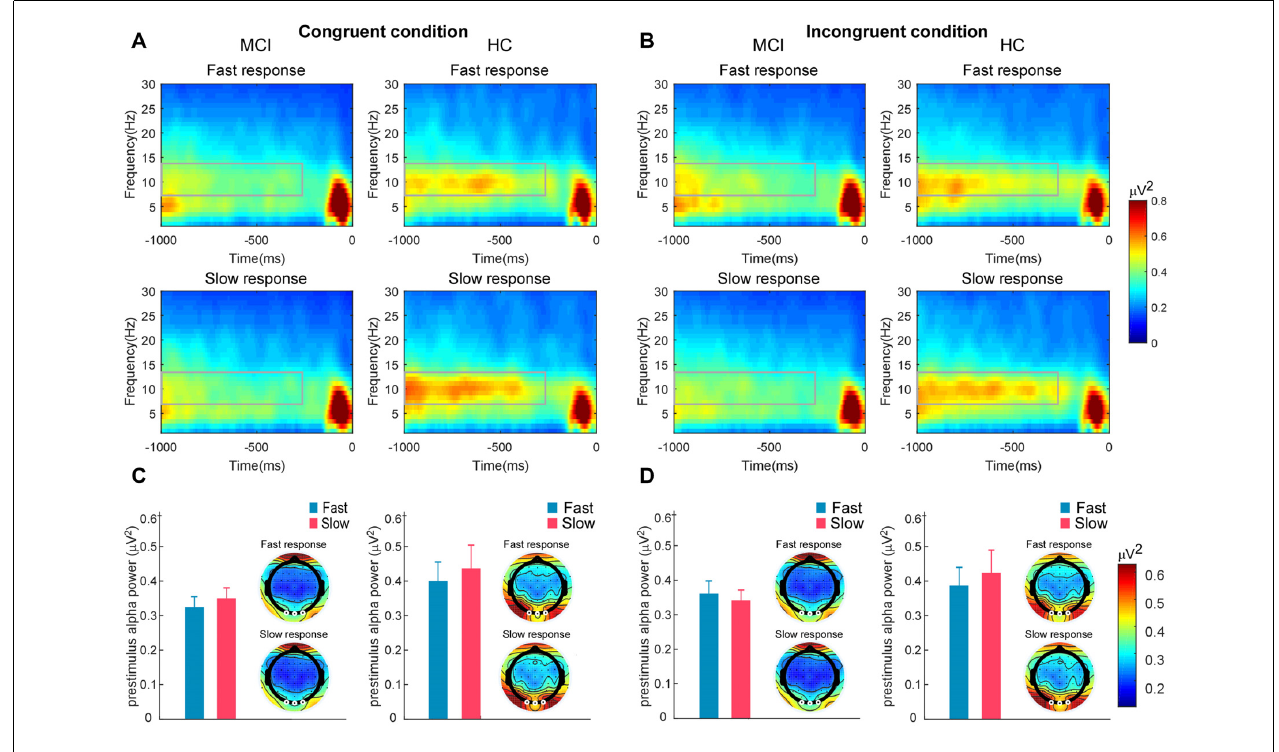
FIGURE 3 | Time–frequency representations highlighted with rectangles illustrate the prestimulus alpha power on the fast and slow trials in the (A) congruent and (B) incongruent conditions for participants with mild cognitive impairment (MCI) and healthy controls (HCs). The signals were recorded at the occipital electrodes of Oz, O1, and O2. Bar charts illustrate the mean prestimulus alpha power on fast and slow trials in MCI participants and HCs under the (C) congruent and (D) incongruent conditions. Error bar represents standard error. Scalp topographies beside bar charts illustrate the scalp distributions of prestimulus alpha power across conditions for the MCI and HC groups.